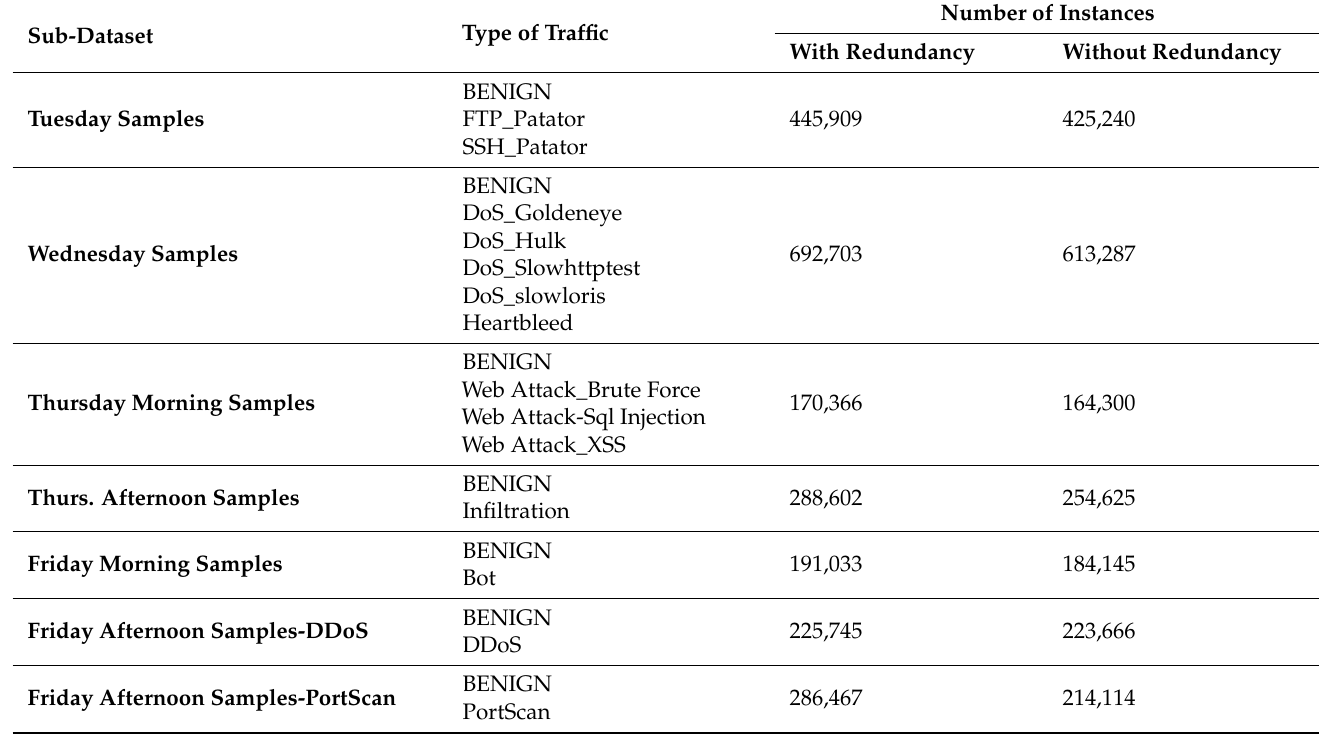
Table 1. Data distribution in CICIDS-2017